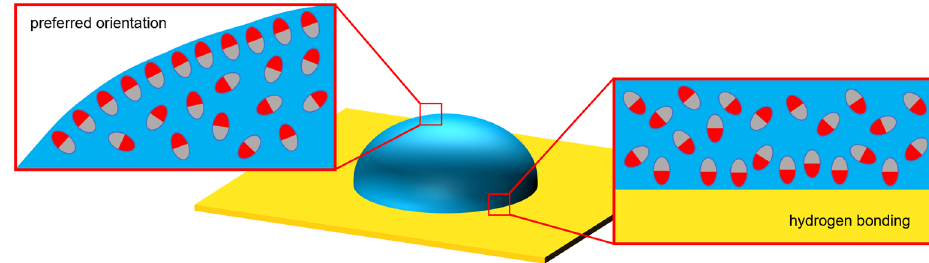
Figure 2. Illustration of interfacial polar molecule behavior and preferred orientation ( left ) and substrate effects such as hydrogen bonding on polar molecules ( right ).